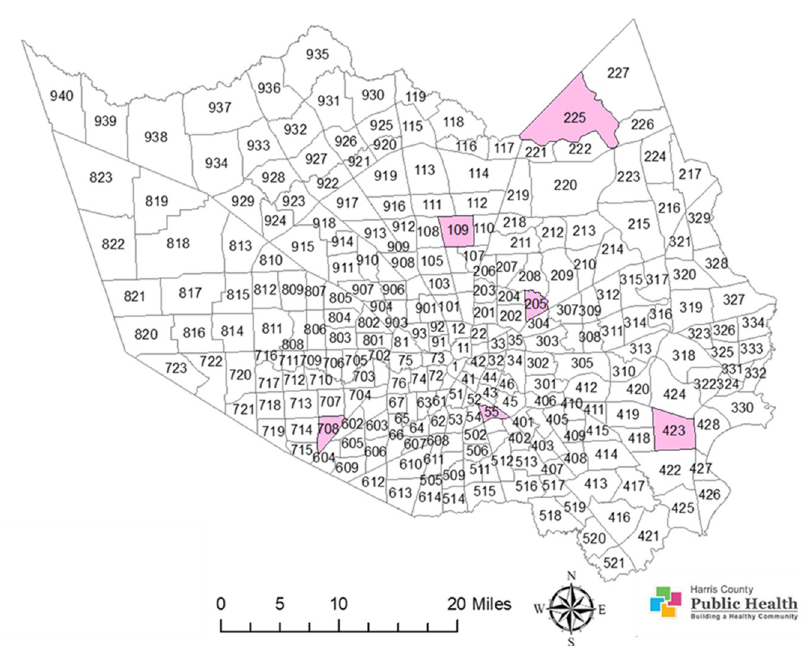
Fig 2. Map of 268 mosquito control operational areas in Harris County. The six operational areas labeled in pink are where egg rafts of Cx . quinquefasciatus were collected for female field cage pyrethroid tests. This map shows the Harris County boundary (map image layer by PHES_AGO; created Jun 7, 2017, updated May 7, 2020) and operational area boundaries (map image layer by PHES_AGO; created Nov 4, 2016, updated May 9, 2020). The layers for county (Map service: Harris county boundary masked) (https://www.arcgis.com/home/item.html?id= a8aa2ef4067348c79ccea62857a2f623) and for Harris County operational area boundaries (MVCD_Operational_Areas) (https://www.arcgis.com/home/item.html?id=66643535e01b42d3aae5d4647f5e1a6c) were created with ArcGIS (https://www.arcgis.com/home/webmap/viewer.html; ESRI, CA) by Harris County Public Health and are publicly available. There are no special restrictions or limitations on the terms of use of the layers applied to this map. The map was completed by assembling these two layers and by marking and coloring the research areas using the ArcMap 10.5 software (ESRI,